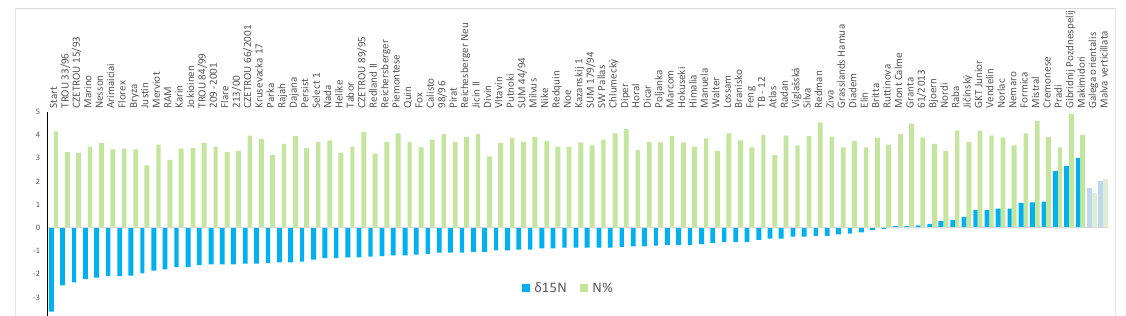
Figure 6. Interpopulation diversity of biological nitrogen fixation as revealed by natural 15 N abundance measurement of red clover leaves ( δ 15 N values are shown in blue). Alongside, N concentrations in the leaves are displayed in green (weight %). The control non-nitrogen symbiotic plant ( Malva verticillata ) and leguminous plant Galega orientalis uninoculated by symbiotic partner are located on the right side.